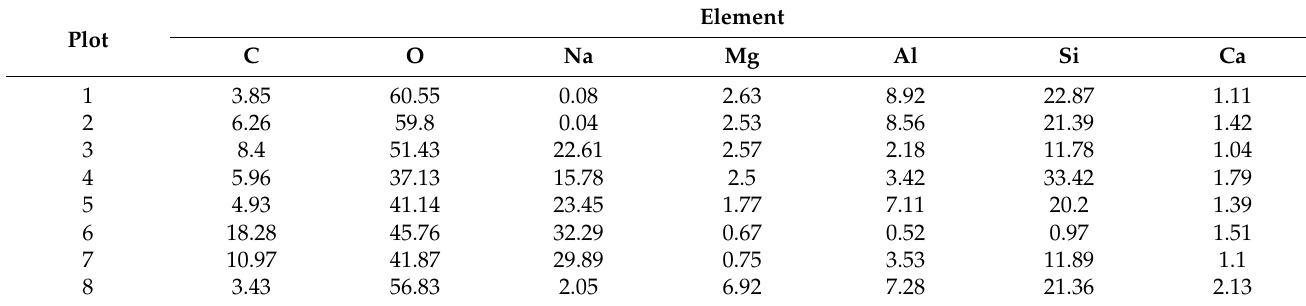
Table 6. SEM-EDS of residue after leaching. (Atomic percent